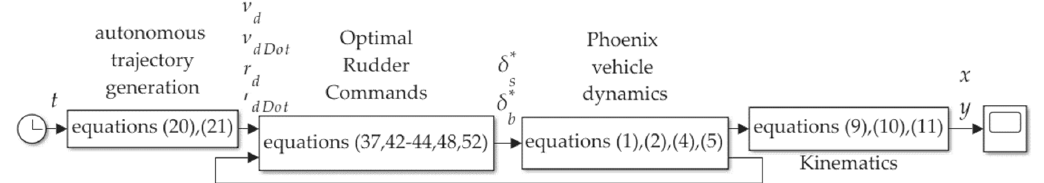
Figure 5. Simulation topology (taken from SIMULINK simulation program) of deterministic artificial intelligence for UUV motion control Equations (24) and (25) for autonomous trajectory generation. Equations (42)–(44) comprise simple learning, while Equations (52) and (48) execute optimal learning. Equation (37) is used to find optimal rudder commands and within that SIMULINK block is also the assertion of self-awareness statements.